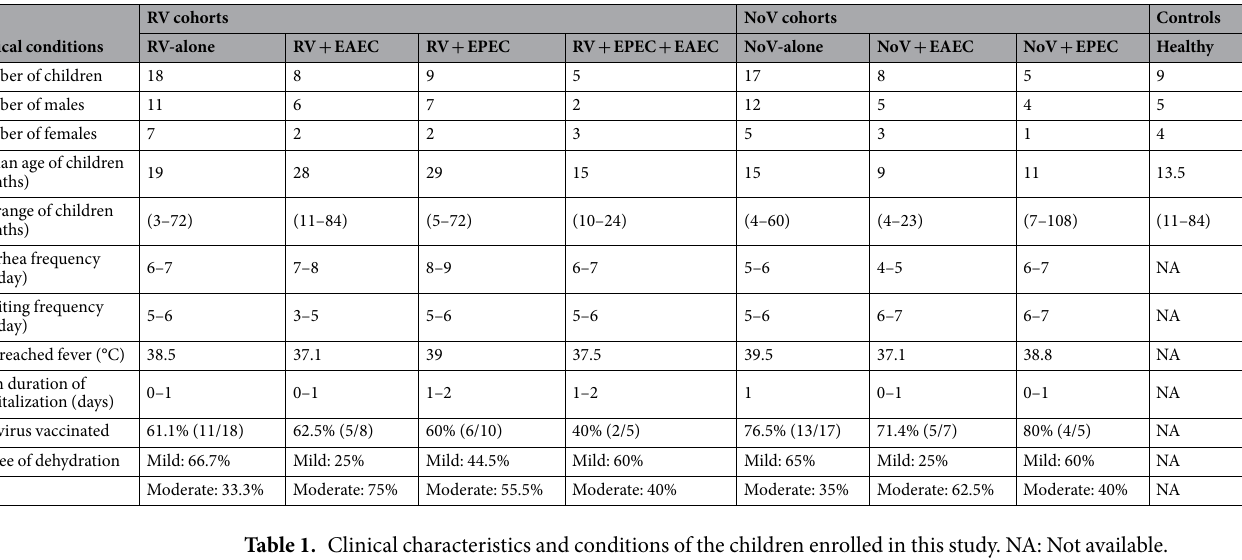
Table 1. Clinical characteristics and conditions of the children enrolled in this study. NA: Not available.